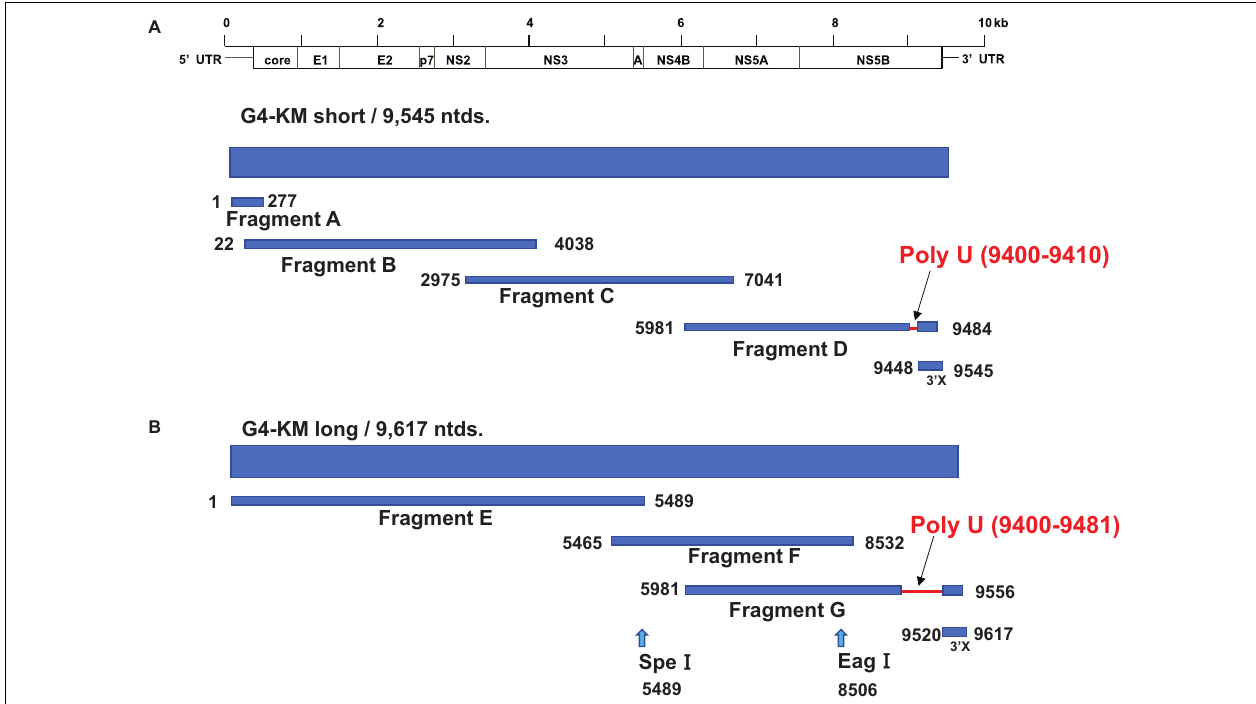
FIGURE 1 | Strategy for HCV-G4 cloning. (A) Strategy for HCV-G4 KM short cloning. Fragment A, B, C, D and 3 (cid:48) X were amplified from cDNA which was reverse transcribed with RNA isolated from HCV-G4- infected chimeric mouse sera. HCV genes were amplified using primer sets of each fragment as described in Table 1 . (B) Fragment E was generated from Fragment A, B, and C using restriction enzymes. We obtained Fragment G with a 71-nucleotide longer poly U sequence, which was used for the construction of HCV-G4 KM long.